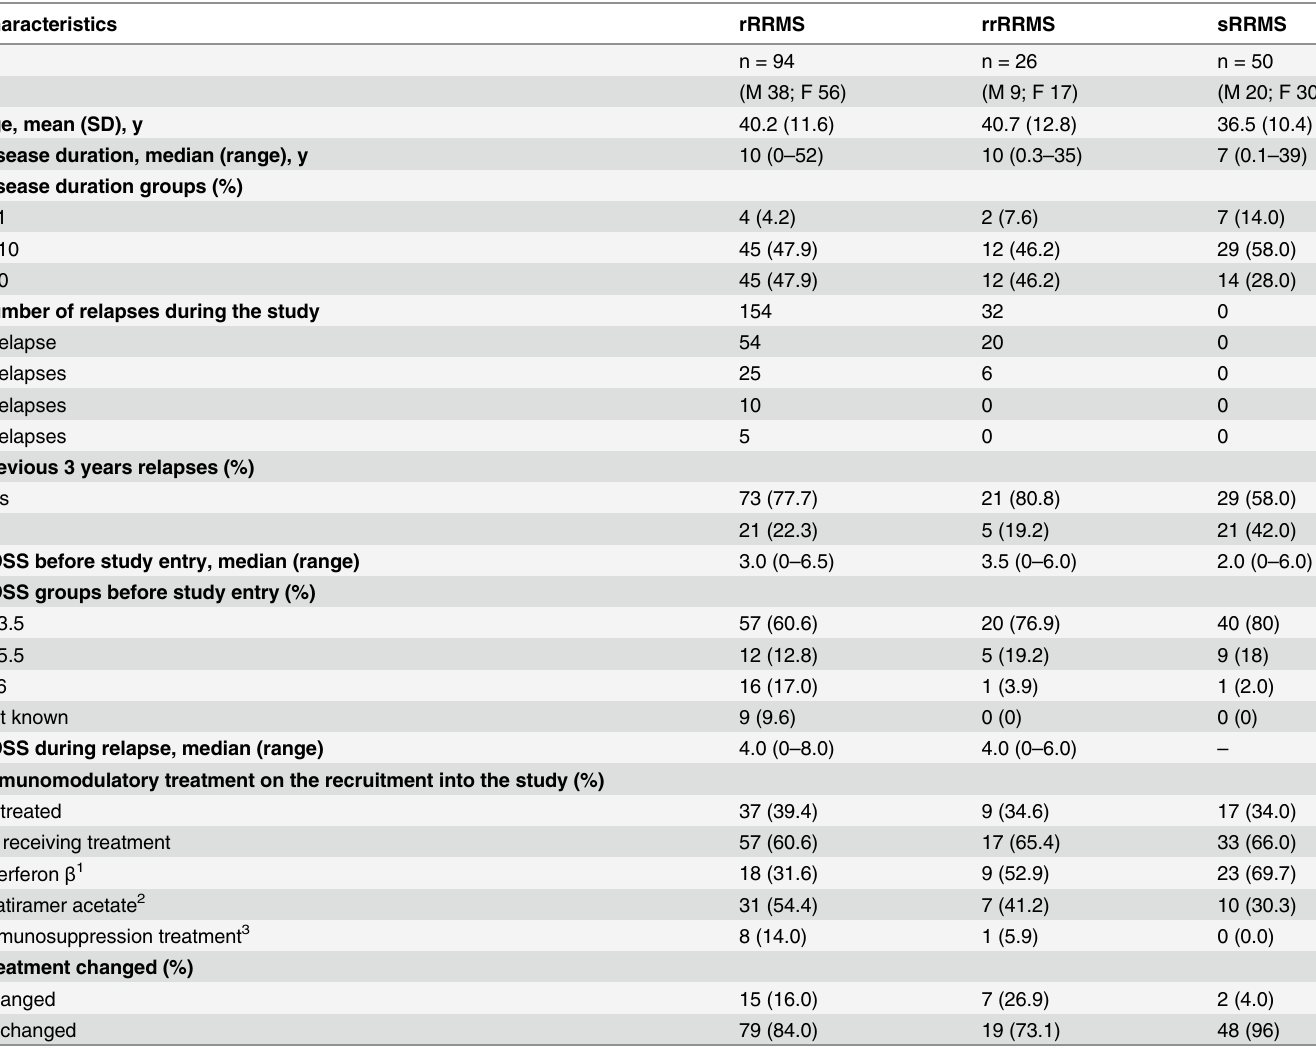
Table 1. Patients with multiple sclerosis (MS)